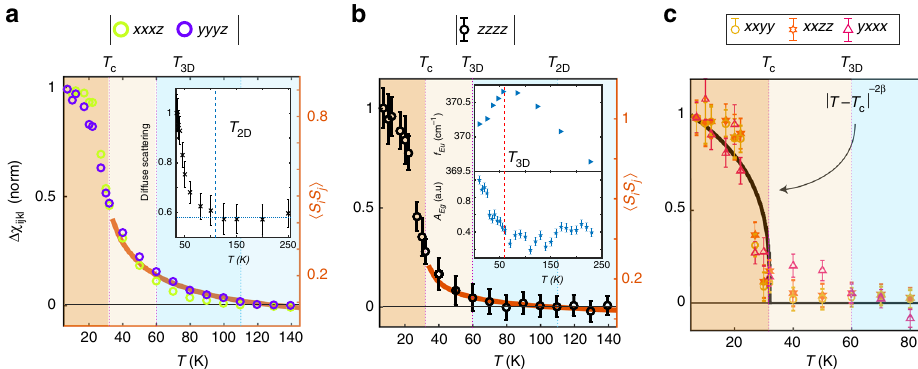
Fig. 3 Temperature evolution of individual susceptibility tensor elements. The values of the a xxxz , yyyz , b zzzz and c remaining elements of the SHG at each temperature extracted through simultaneous fi tting to all four polarization con fi gurations of the RA data (see text). For susceptibility tensor χ ijkl every element, a high temperature background derived from the data above T = 150 K was subtracted off. The background subtracted curves ( Δ χ then each normalized to their values at T = 7 K. Error bars are the least squared errors of the fi ts, which are smaller than the data symbols in panel a . Solid lines in panels a and b are the calculated intralayer and interlayer spin correlator respectively. The line in panel c is the function T (cid:4) T c j j (cid:4) 2 β , where β is the critical exponent of the magnetization. The two elements zzxx and zzxy are not displayed in c for clarity because their fi tted values are very small, resulting in much larger error bars. However their trend follows that of the xxyy , xxzz and yxxx elements shown in c (see Supplementary Note 4). Diffuse magnetic neutron scattering data from CrSiTe 3 reproduced from ref. 7 is shown in the inset of a . The inset of b shows the frequency of the E u phonon (top) and amplitude of the E g phonon (bottom), which are respectively reproduced from ref. 20 and measured using impulsive stimulated Raman scattering